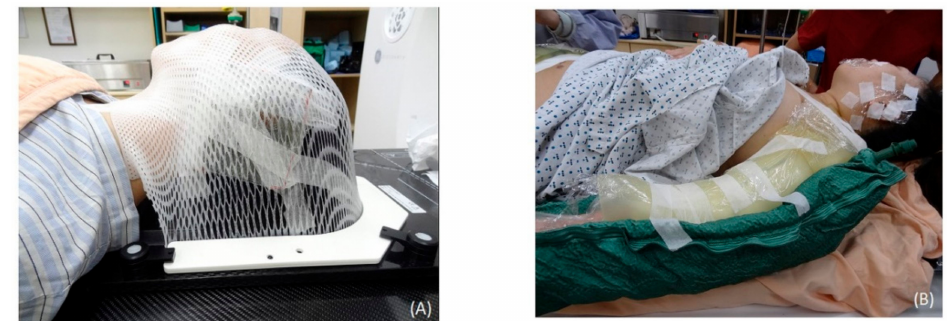
Figure 1. CT simulation setup conditions for patients with keloids in di ff erent areas after resection. ( A ) A patient with a keloid on the left ear was immobilized by a U-frame head and neck immobilization system (CIVCO Radiotherapy, Orange City, IA, USA), with her face turned to the contralateral side to expose the operative ear. ( B ) A patient with complicated keloids on the body was immobilized by a Body Vac Cushion (Klarity Medical, Newark, OH, USA) in the supine